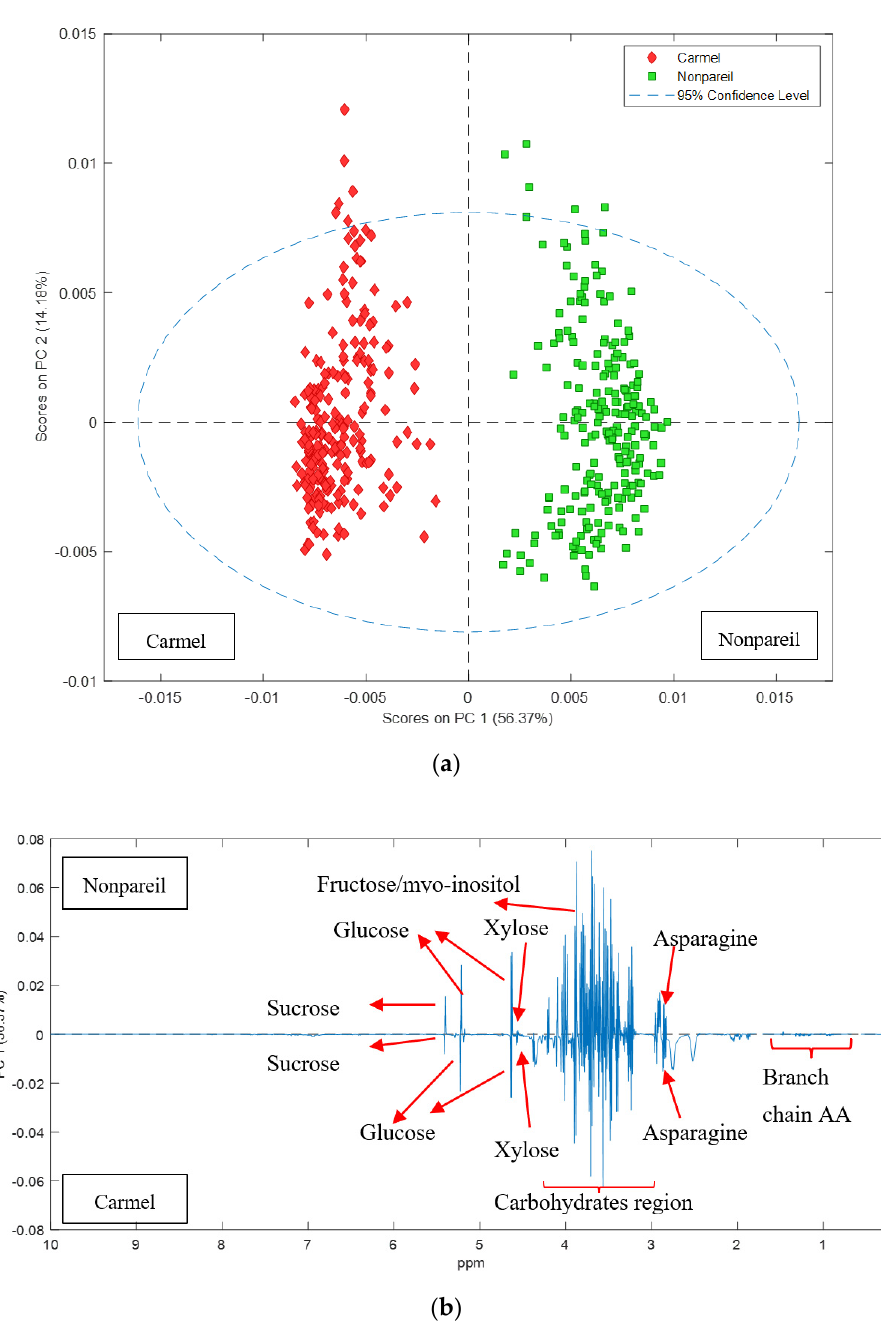
Figure 1. PCA score and loadings plots of 1H NMR data of Nonpareil and Carmel hulls: ( a ) PCA scores plot showing clear separation of Nonpareil and Carmel hull samples regardless of the treatment; ( b ) loadings plot of PC1 variables indicates that sucrose and asparagine are elevated in Nonpareil compared to Carmel.